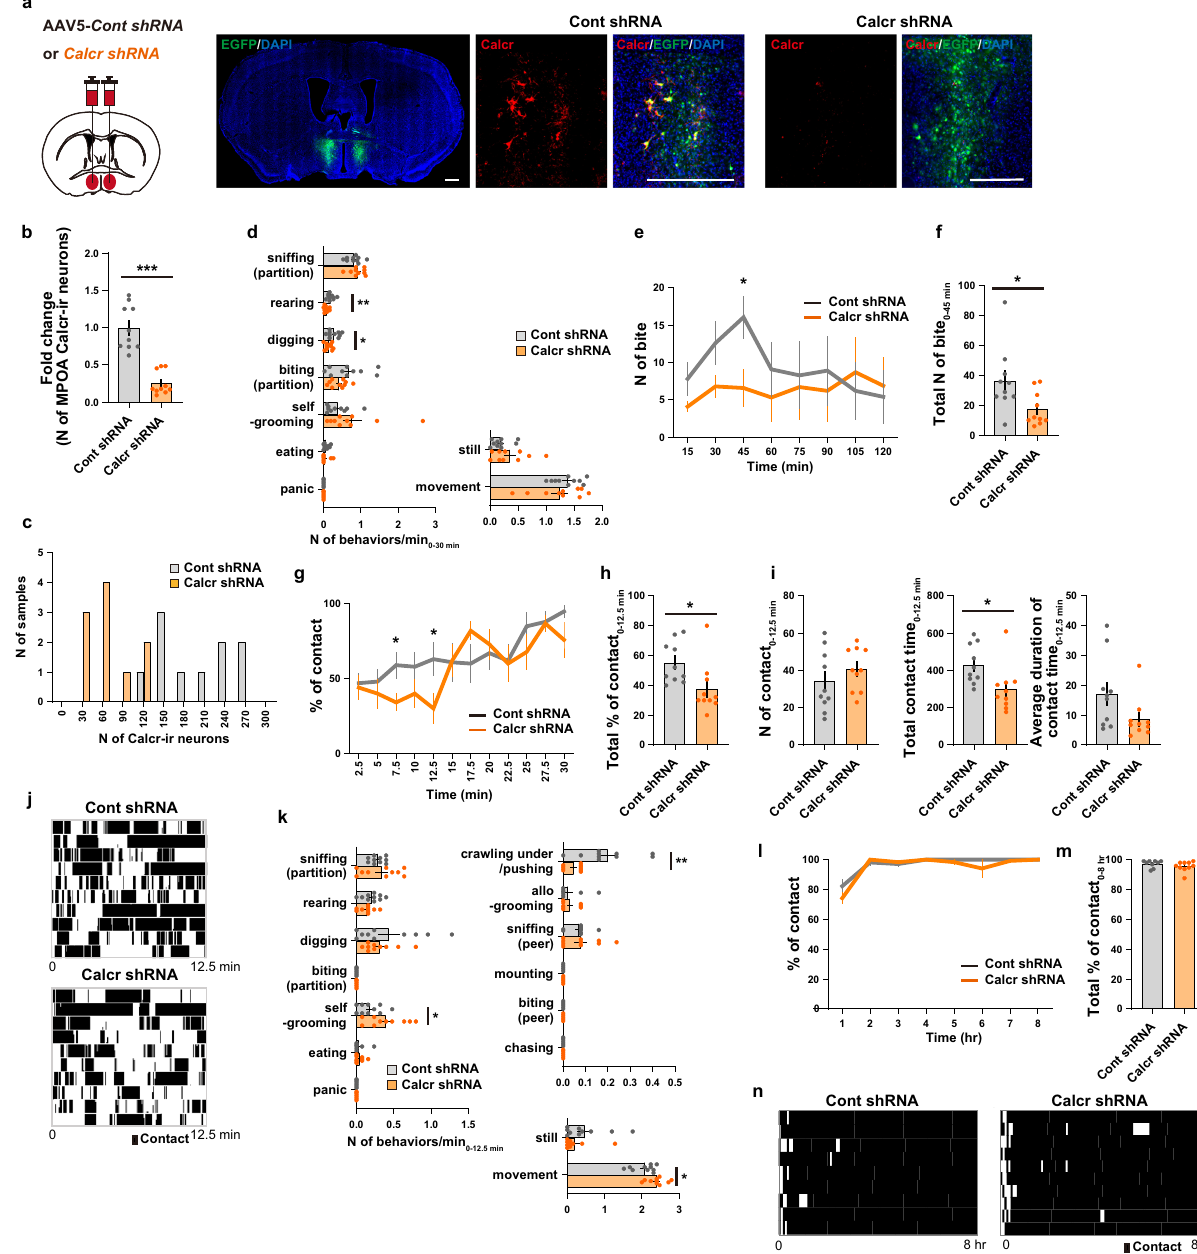
Fig. 6 Targeted knockdown of Calcr in the cMPOA blocks behavioral responses to somatic isolation and reunion. a Left panel: experimental procedure. Two weeks prior to testing, female mice were injected with AAVs expressing shRNA-EGFP for the speci fi c knockdown of Calcr (Calcr shRNA) or with a virus carrying scrambled shRNA (Cont shRNA). Other panels: representative coronal sections of shRNA-EGFP viral expression in the cMPOA showing the ef fi cacy of Calcr shRNAs. Scale bars, 500 μ m. b, c Quanti fi cation of number (N) of Calcr-immunoreactive (Calcr-ir) neurons in the MPOA ( n = 10 mice per group). The number of Calcr-ir neurons signi fi cantly decreased in the cMPOA after Calcr shRNA injection. d Quanti fi cation of behaviors (number of occurrences per min) seen during somatic isolation for 30 min ( n = 10 mice per group). e Time course analysis of the biting responses ( n = 10 mice per group). ( f ) Total number of biting responses occurring during 45 min ( n = 10 mice per group). g Percentage of social contacts (number of occurrences divided by total number of observations at a time point) over time ( n = 10 mice per group). h Percentage of social contacts (total number of occurrences divided by total number of observations) during 12.5 min. ( i ) Quanti fi cation of the number of contacts, total contact time, and average duration of contact time. These data were analyzed using continuous video recording during 12.5 min ( n = 10 mice per group). j Raster plots showing the effects of Calcr shRNA injection in the MPOA on social contacts. k Quanti fi cation of behaviors (number of occurrences per min) seen during social reunion for 12.5 min ( n = 10 mice per group). l Analysis of the percentage of social contacts (number of occurrences divided by total number of observations at a time point) over time (Cont shRNA: n = 9 mice and Calcr shRNA: n = 10). ( m ) Percentage of social contacts (total number of occurrences divided by total number of observations) during 8 h (Cont shRNA: n = 9 mice and Calcr shRNA: n = 10). n Raster plots showing the effects of Calcr shRNA injection in the MPOA